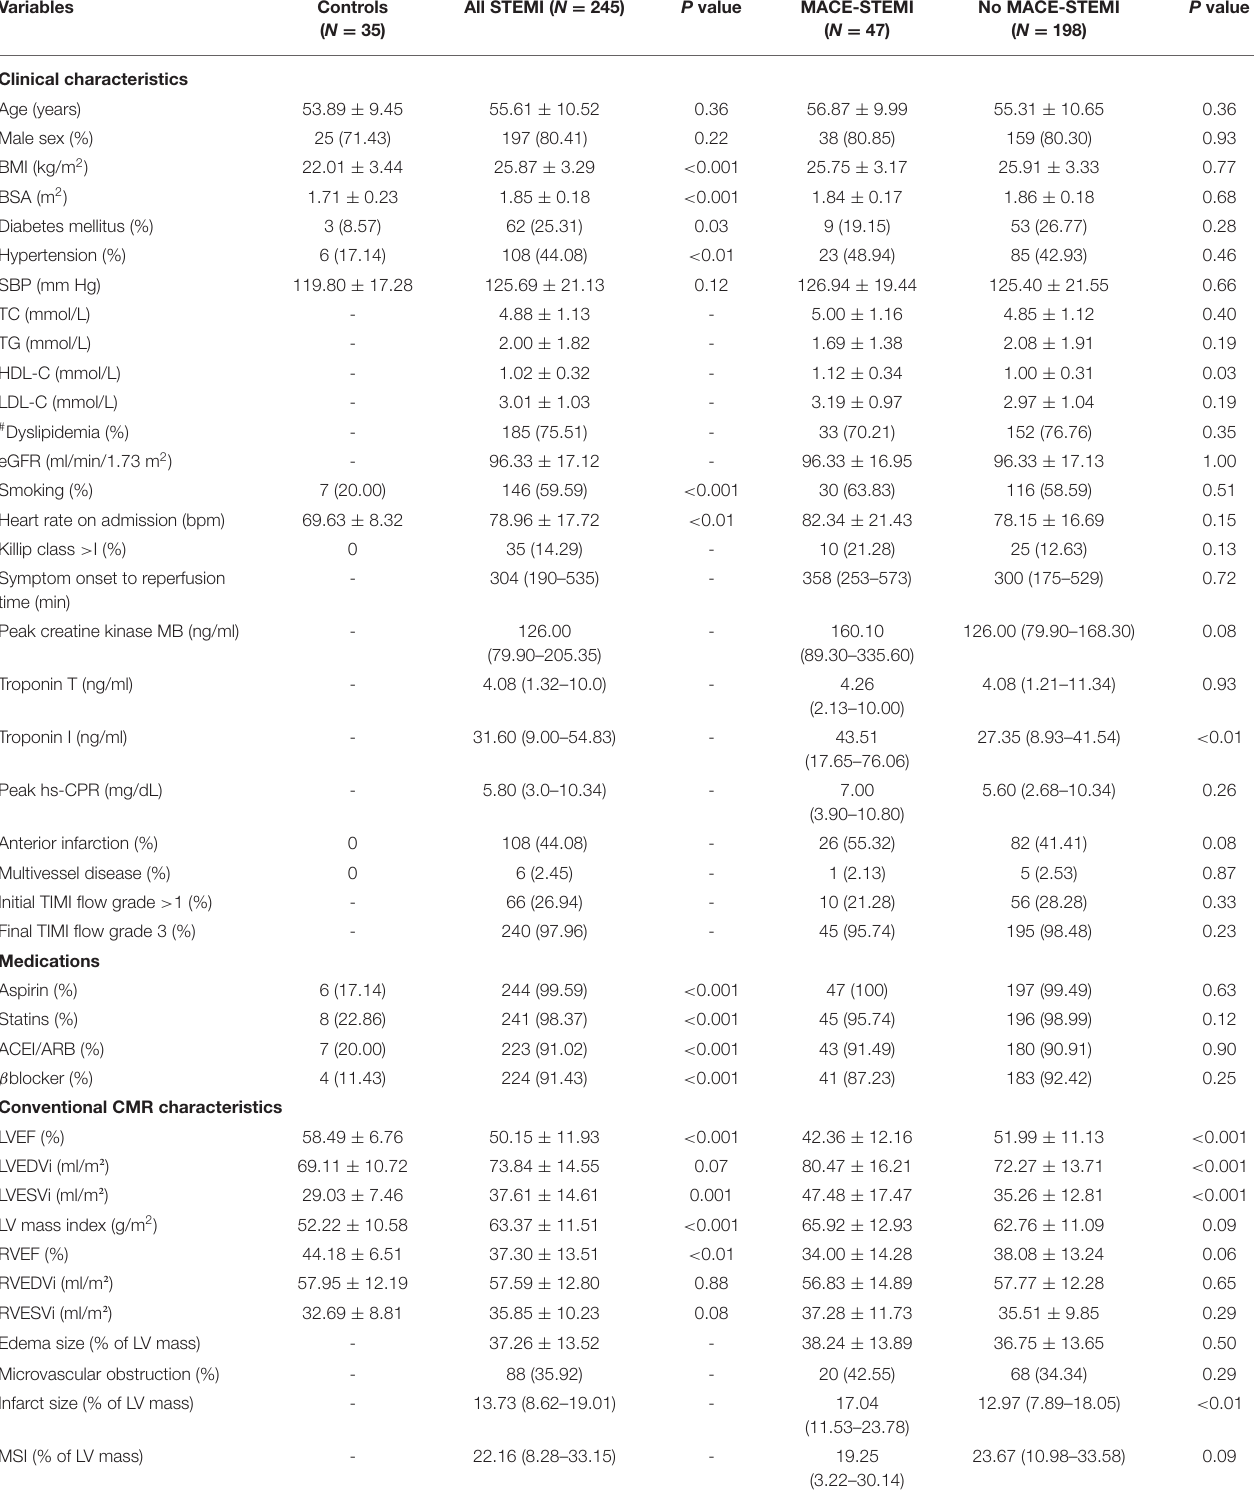
TABLE 1 | Baseline characteristics of study population.